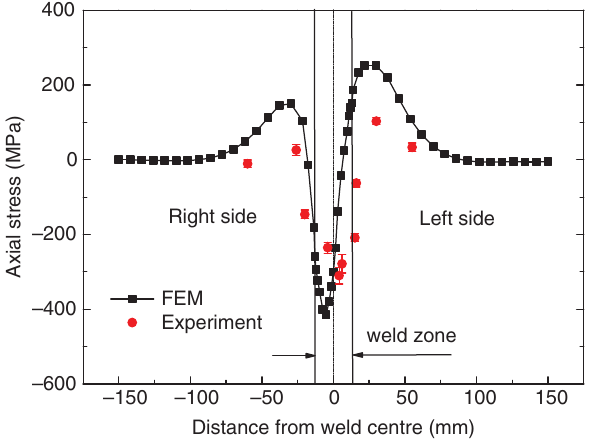
Figure 5: Comparison of axial stress distribution between predic- tions and measurements along path